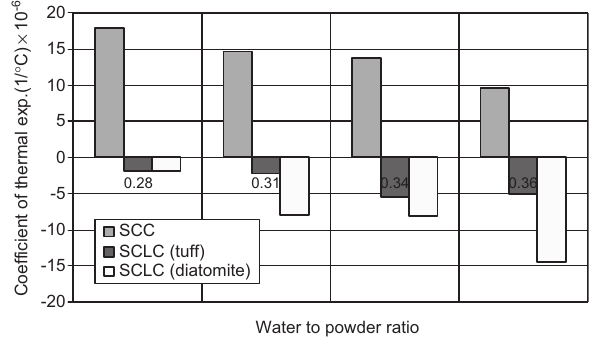
Figure 16 Comparison of CTE values of SCC and SCLC at 1000 °